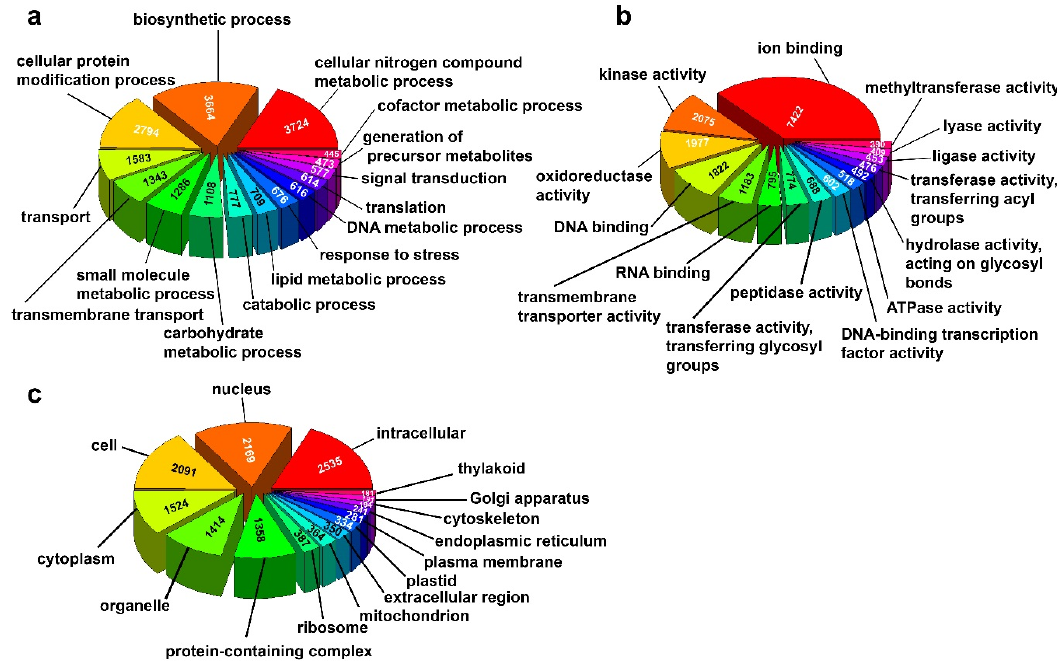
Figure 2. Gene Onthology (GO) annotation of the assembled S. hispanica transcriptome. All GO terms are grouped into three ontologies. ( a ) Biological Process; ( b ) Molecular Function; ( c ) Cellular Component. The numbers indicate the number of transcripts in each category.